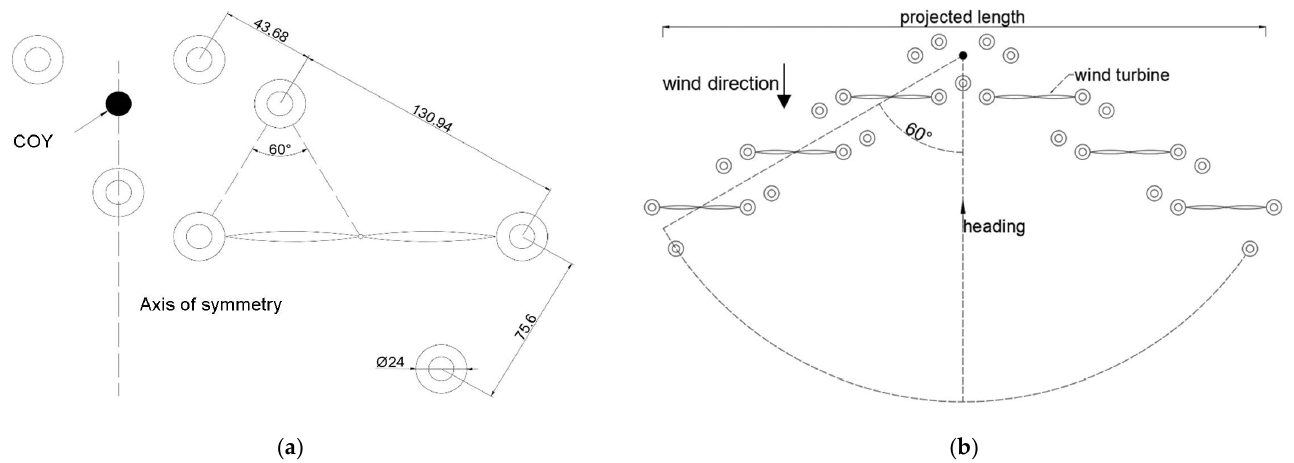
Figure 2. Dimension of the module and platform: ( a ) the module; ( b ) the six-turbine platform (top view, m).